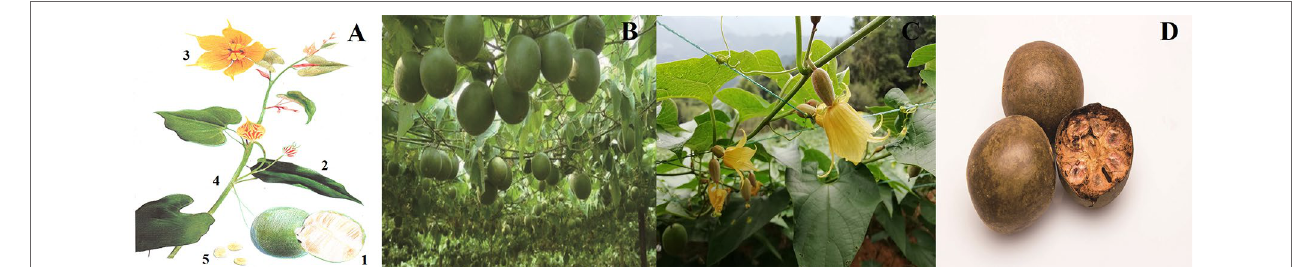
FIGURe 1 | Images of S. grosvenorii. (A) Line drawing of S. grosvenorii : 1. fruit; 2. leaf; 3. flower; 4. stem; 5. seed. (B) and (C) Plant of S. grosvenorii . (D) The medicinal material of S. grosvenorii